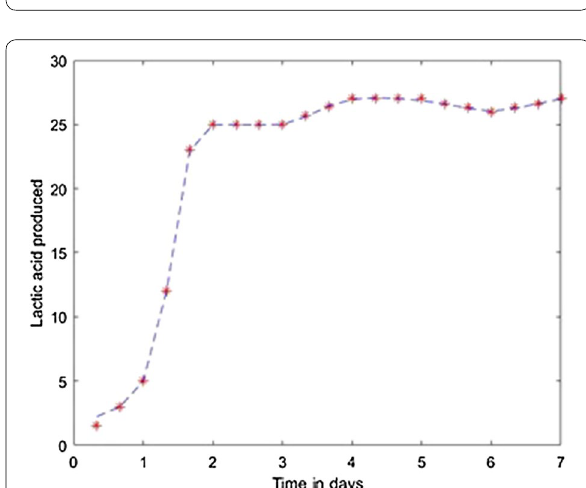
Fig. 11 Model results obtained with the Polak Ribiere Conjugate Gradient method